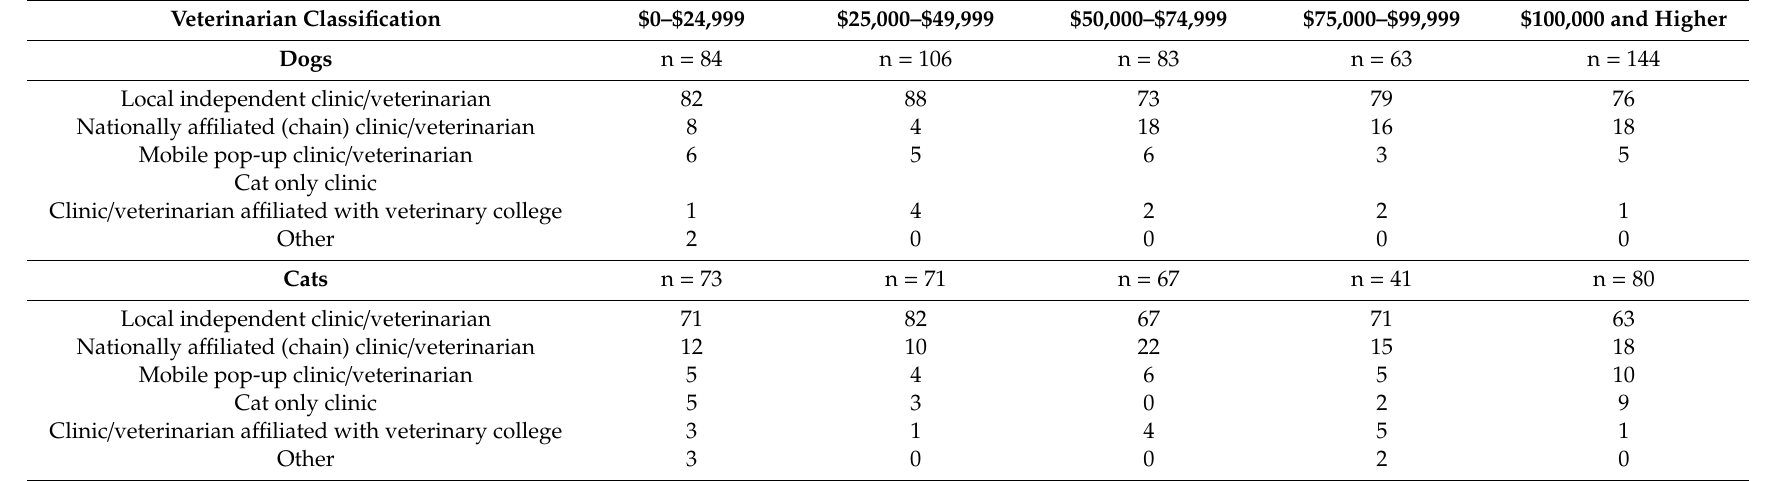
Table A5. Veterinary Classification, by